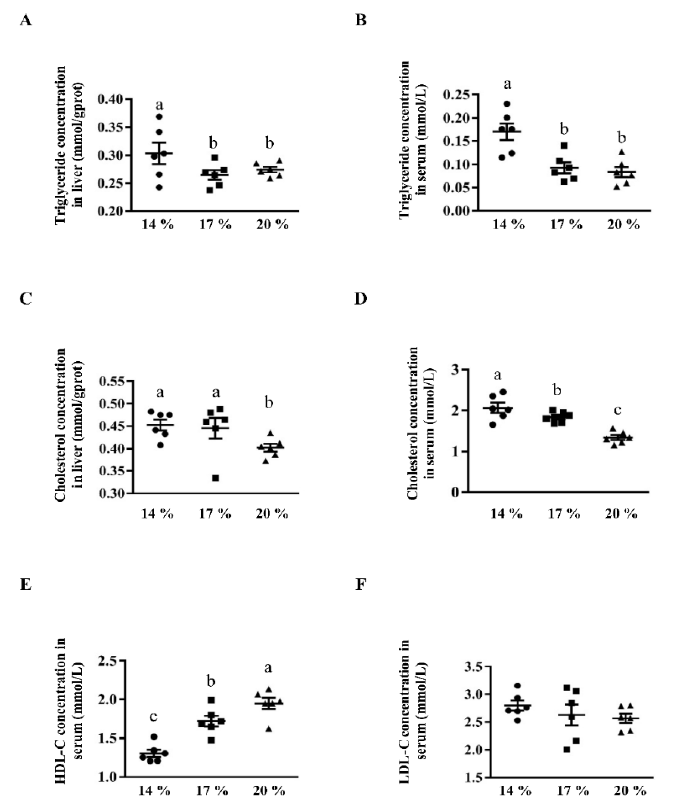
Figure A1. Effect of dietary crude protein level on the concentration of triglyceride and cholesterol in liver and serum. Triglyceride concentration in liver ( A ) and serum ( B ). Cholesterol concentration in liver ( C ) and serum ( D ). HDL-C ( E ) and LDL-C ( F ) concentration in serum. Values are means ± SEMs, n = 6. Means without a common letter differ, p < 0.05. HDL-C, high-density lipoprotein cholesterol; LDL-C, low-density lipoprotein cholesterol.